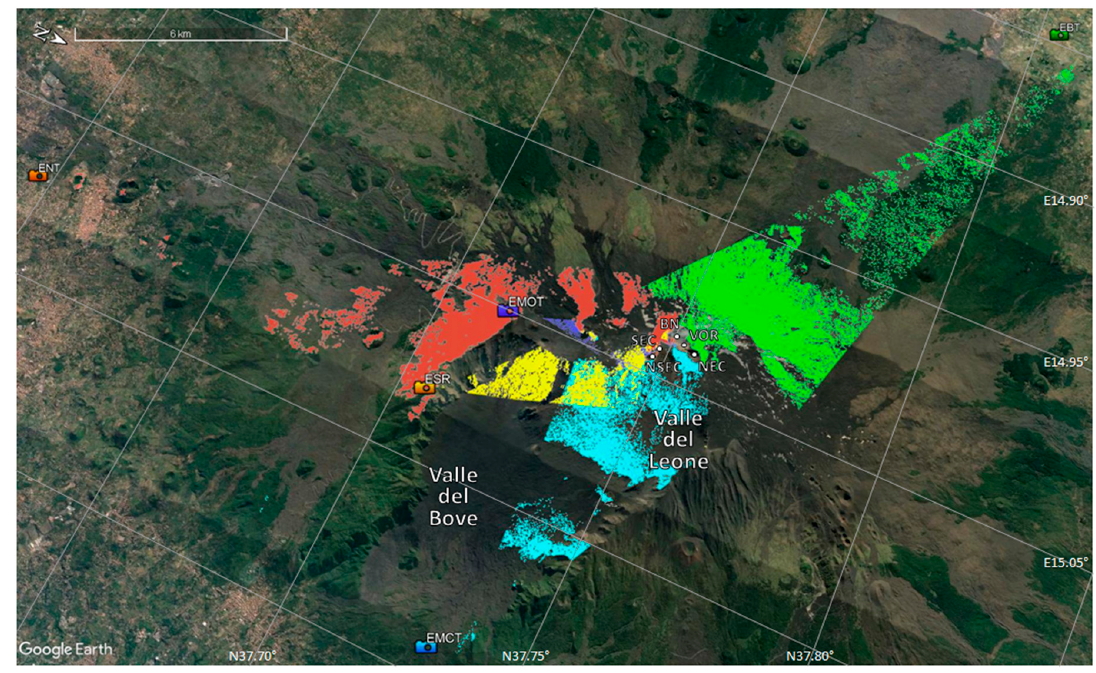
Figure 1. Location of thermal cameras on Etna. Google Earth view of summit area with the five active craters: North-East Crater (NEC), Voragine (VOR), Bocca Nuova (BN), South-East Crater (SEC) and New South-East Crater (NSEC). “Valle del Bove” is a huge depression on Etna’s eastern flank. “Valle del Leone” is the northern east part of “Valle del Bove”. Colors represent the different views of the thermal cameras: ENT (red), ESR (yellow), EMOT (violet), EBT (green) and EMCT (azure). In Figure 2, the locations of Etna’s summit craters are shown with respect to each thermal camera view. Each color line is associated with the corresponding crater name, whereas the arrows indicate the positions of the corresponding craters that are in the background and out of sight.